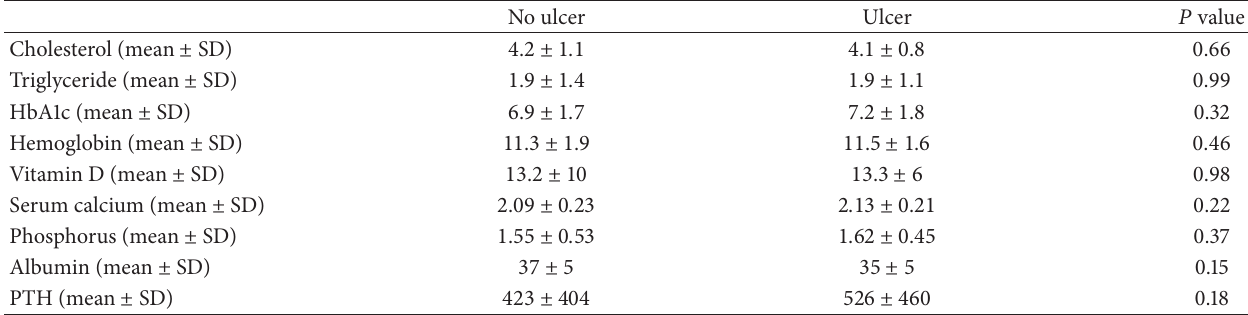
Table 2: Laboratory